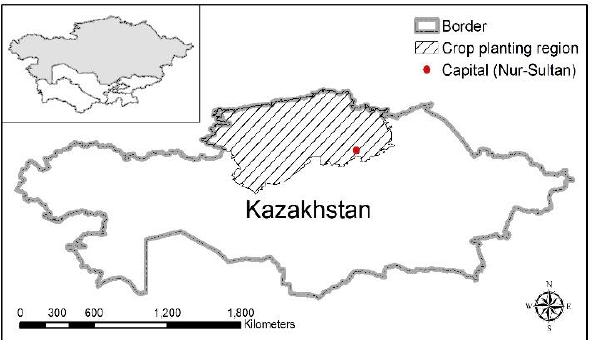
Figure 1. Location of the study area, shadowed part in the north is the traditional wheat planting